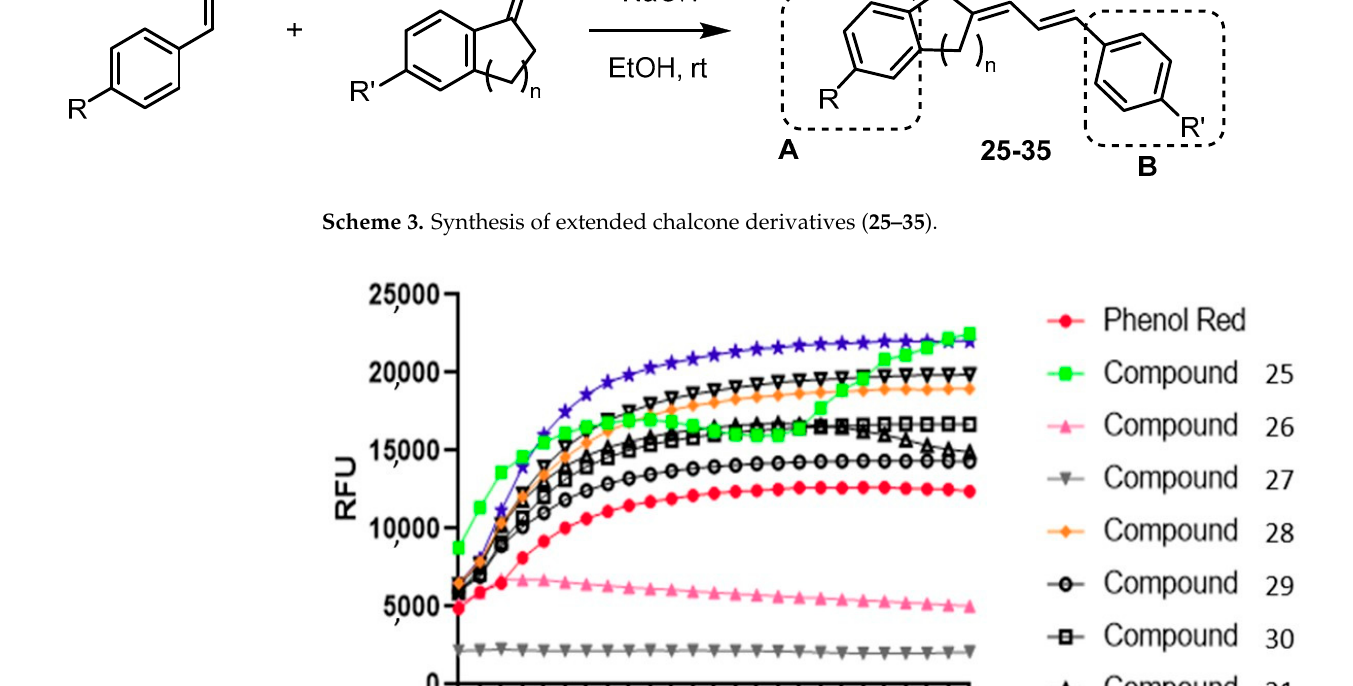
5 Figure 3. Select ThT fluorescence assay of chalcone compounds 14,16, and 20 at 100 μ M. Phenol red 100 μ M is a positive control. Fluorescence was recorded every 5 min for 120 min. Curcumin’s extended conjugation (specifically in its enol tautomeric form) inspired